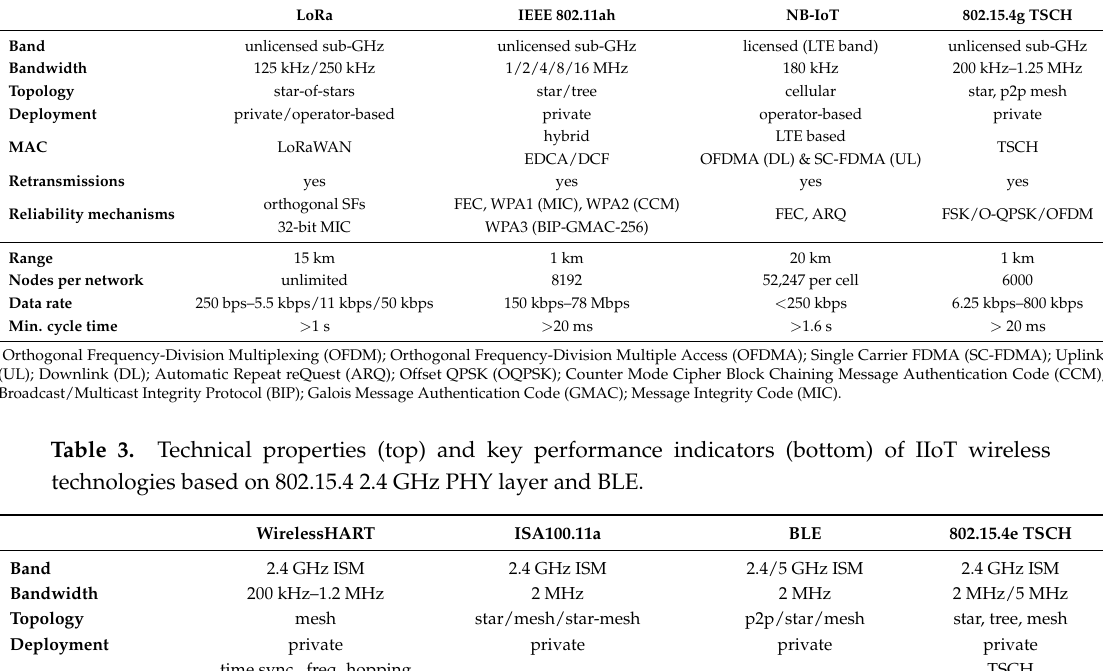
Table 2. Technical properties (top) and key performance indicators (bottom) of sub-GHz wireless technologies for the IIoT domain.